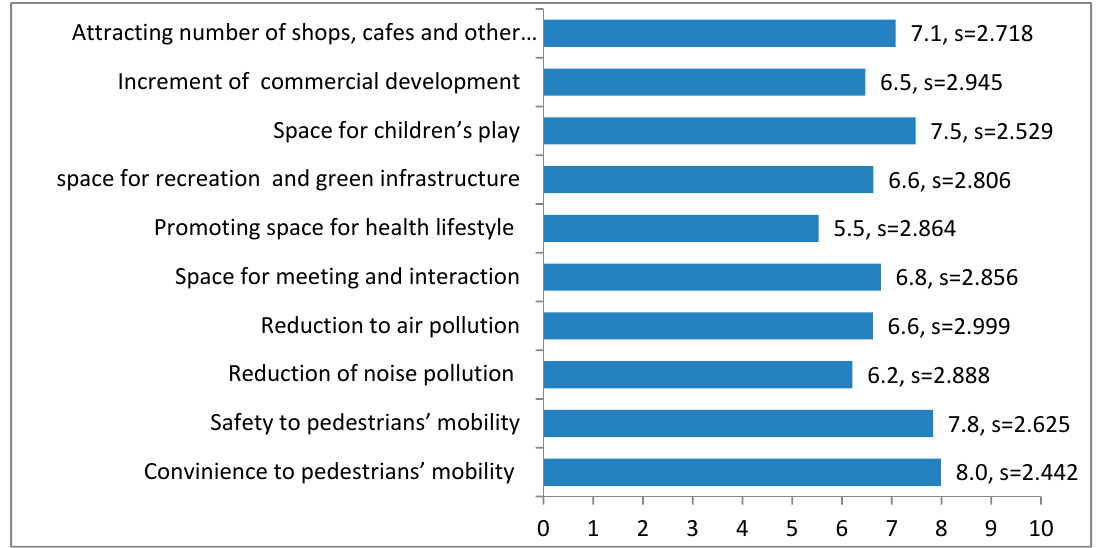
Figure 3. Evaluation of the advantages of pedestrian streets using a 10-point Likert scale (means and standard deviations).